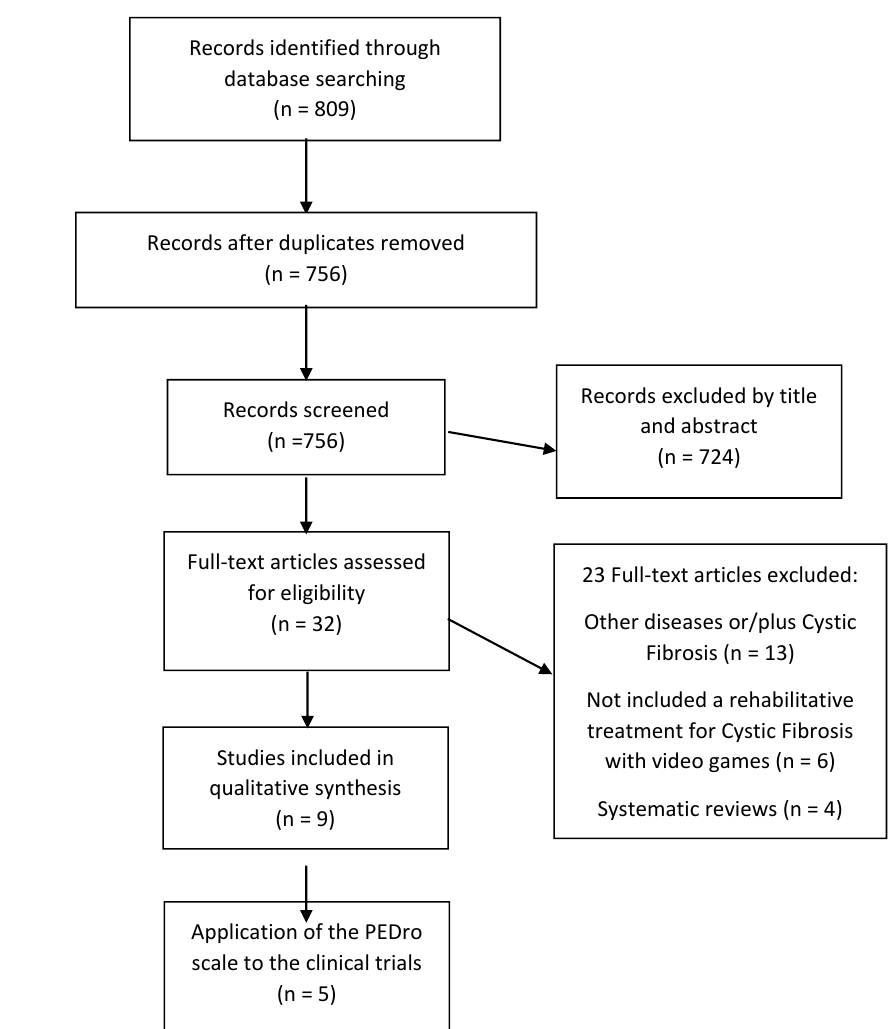
Figure 1. The selected articles from the databases.